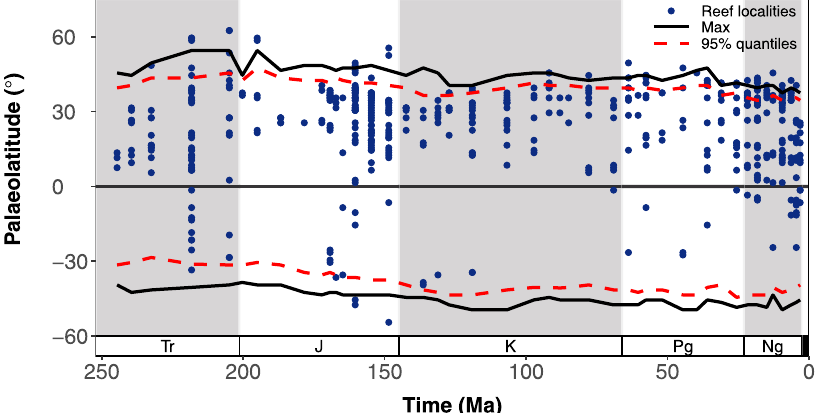
Fig. 6 Stage-level estimates of warm-water coral reef zone from the Anisian (Triassic) to the Piacenzian (Neogene). Reef zone (black lines) is de fi ned as the most poleward palaeolatitude of suitable habitat in each hemisphere (North and South) under binary threshold ‘ LTP ’ (least training presence). The 95% quantiles of estimated stage-level reef zone are depicted by the dashed red line, and fossil coral reef localities are indicated by the blue points. Period abbreviations are as follows: Triassic (Tr), Jurassic (J), Cretaceous (K), Paleogene (Pg), and Neogene (Ng).